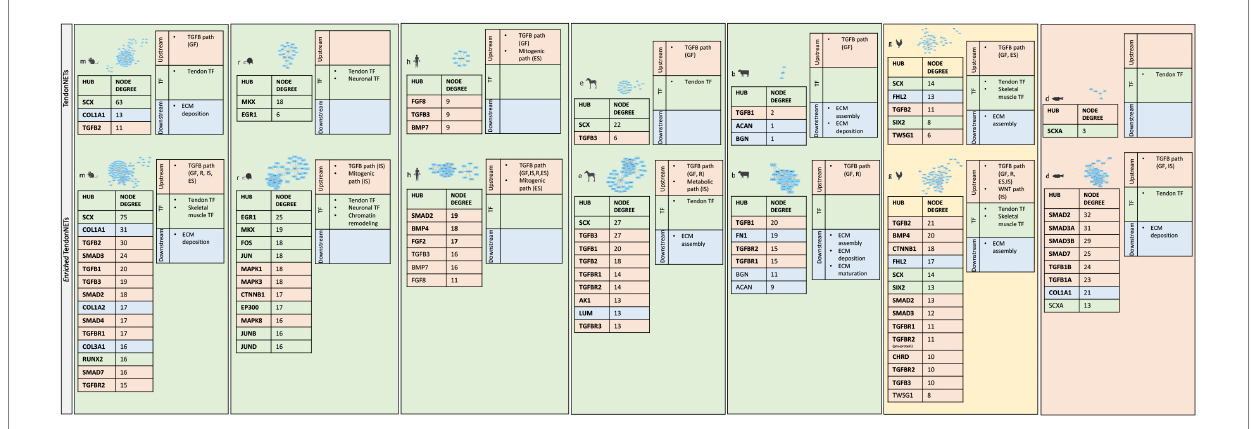
FIGURE 9 Hub identification and ranking in each Enriched TendonNET. The ranking was based on the value of the hub node degree. No bold font indicates molecules with a hub role in the TendonNETs (detailed in Figure 4). The different colors of the hub molecules allow us to identify the signaling layer of pertinence. In orange were reported nodes of the upstream layer, in green nodes of the TF layer, and in light blue nodes of the downstream layer. ES, extracellular signaling; IS, intracellular signaling; R, receptor; GF, growth